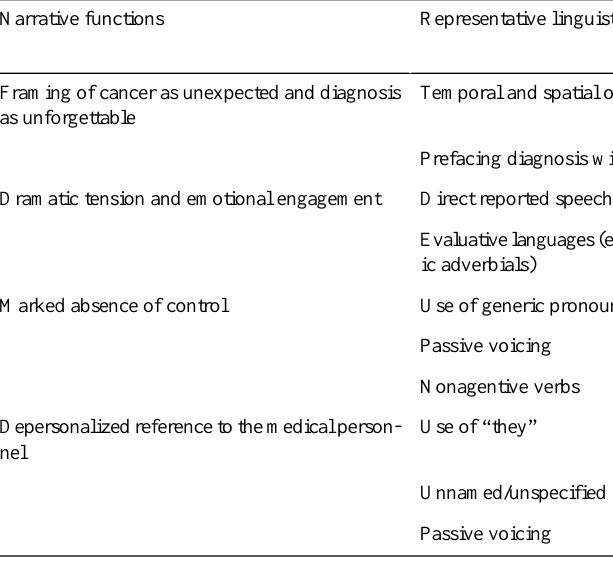
DNs)Representative linguistic featuresNarrative